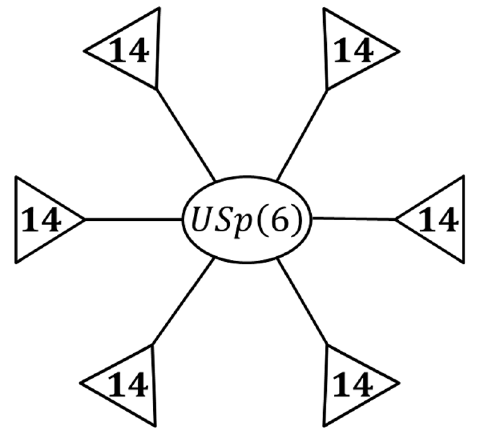
Figure 1 . Triality frame